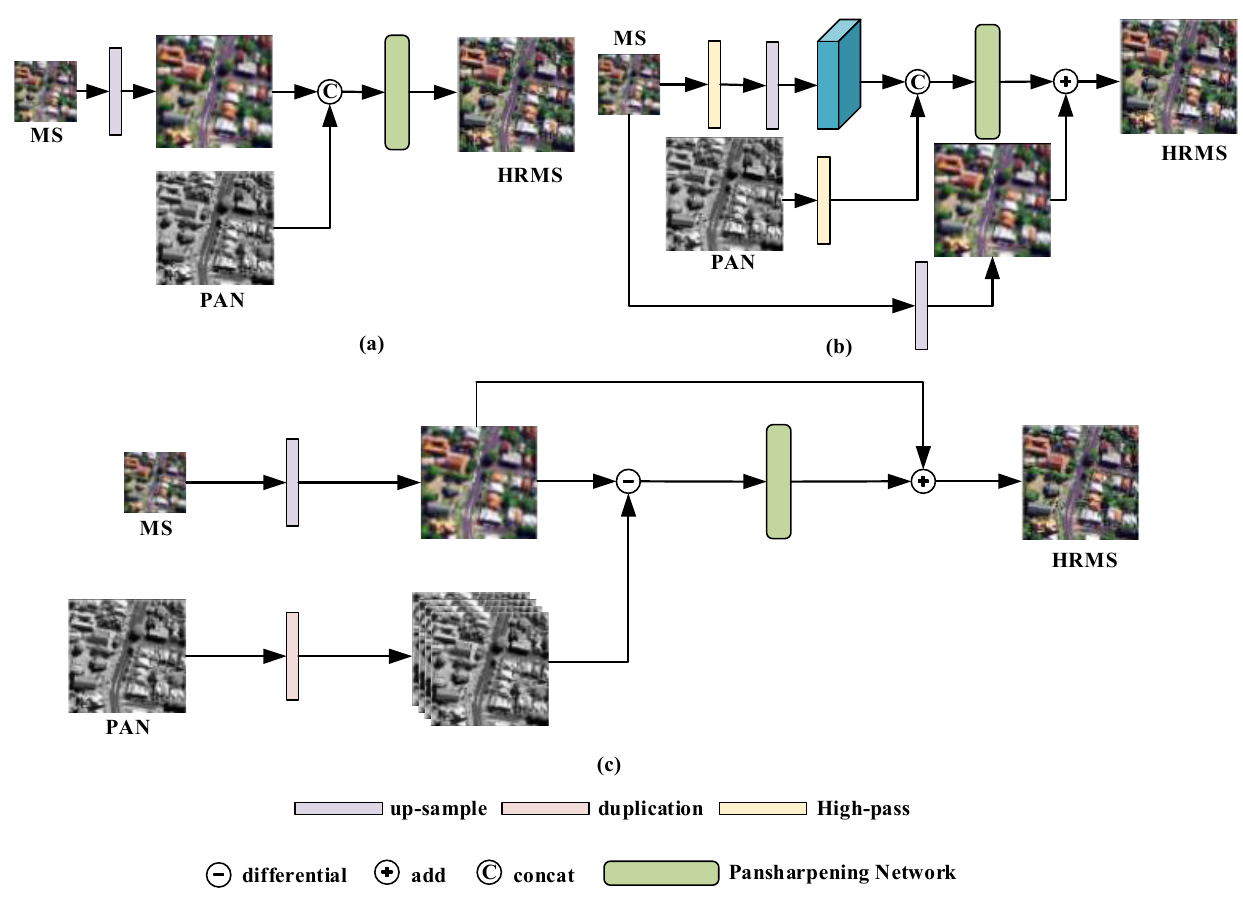
Figure 1. Different strategies of input: ( a ) the overlapping original information strategy, ( b ) the overlapping high-pass information strategy, and ( c ) the differential information mapping strategy.